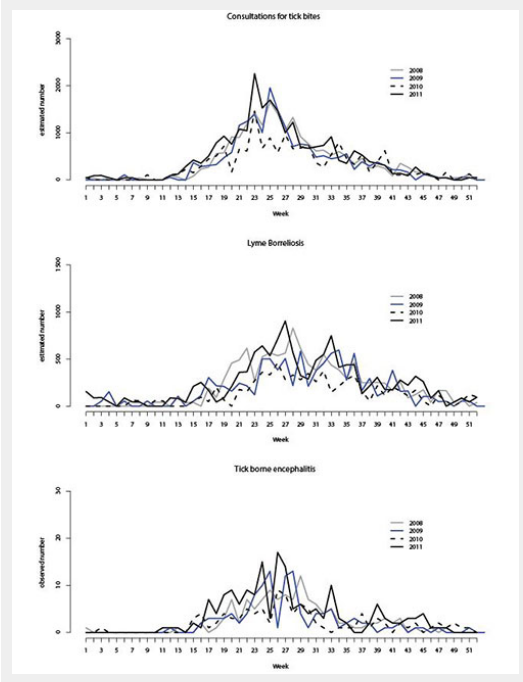
Seasonal time trends of treated tick bites, Lyme borreliosis (both estimated numbers of cases) and tick borne encephalitis (observed number of cases), Switzerland, 2008 to 2011. The week of the year is defined according to ISO 8601. The estimated numbers of consultations for tick bites or Lyme borreliosis, respectively, are represented in Panel 1 and 2. Panel 3 represents the seasonal trend in tick borne encephalitis